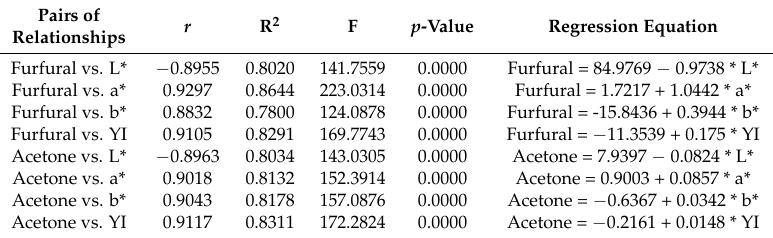
Table 4. Linear regression